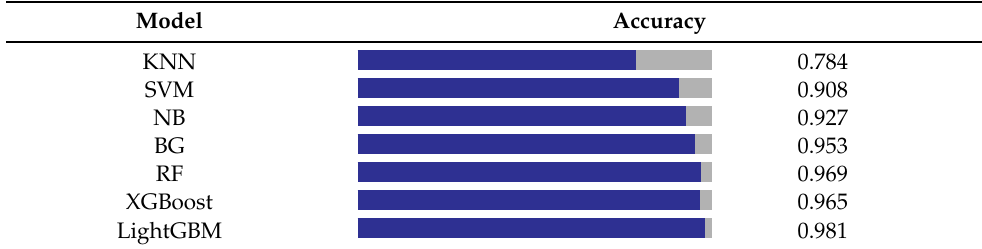
Table 4. Key metrics of the optimized LightGBM model.